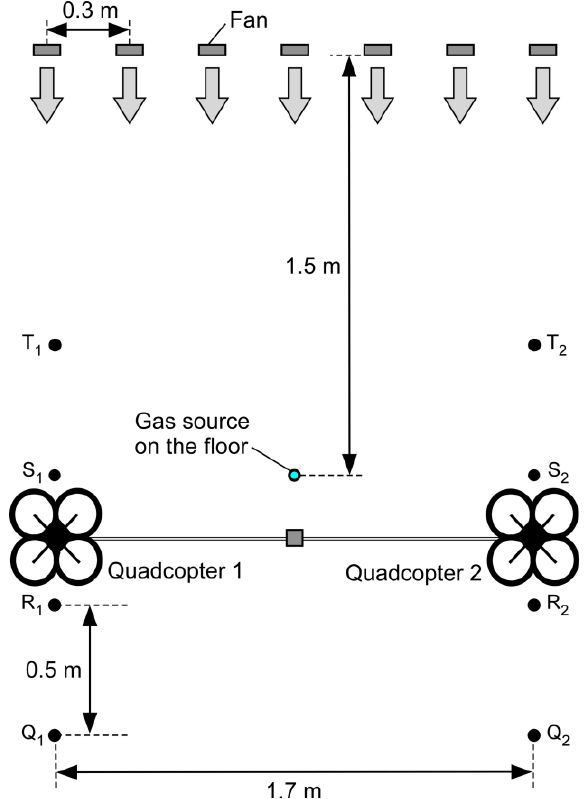
Figure 13. Setup of the flight experiment under cross-flow conditions (top view). Seven electric fans were aligned to generate a uniform airflow field. Quadcopter 1 was moved from point Q 1 through points R 1 and S 1 to point T 1 , while quadcopter 2 was moved from point Q 2 through points R 2 and S 2 to point T 2 .